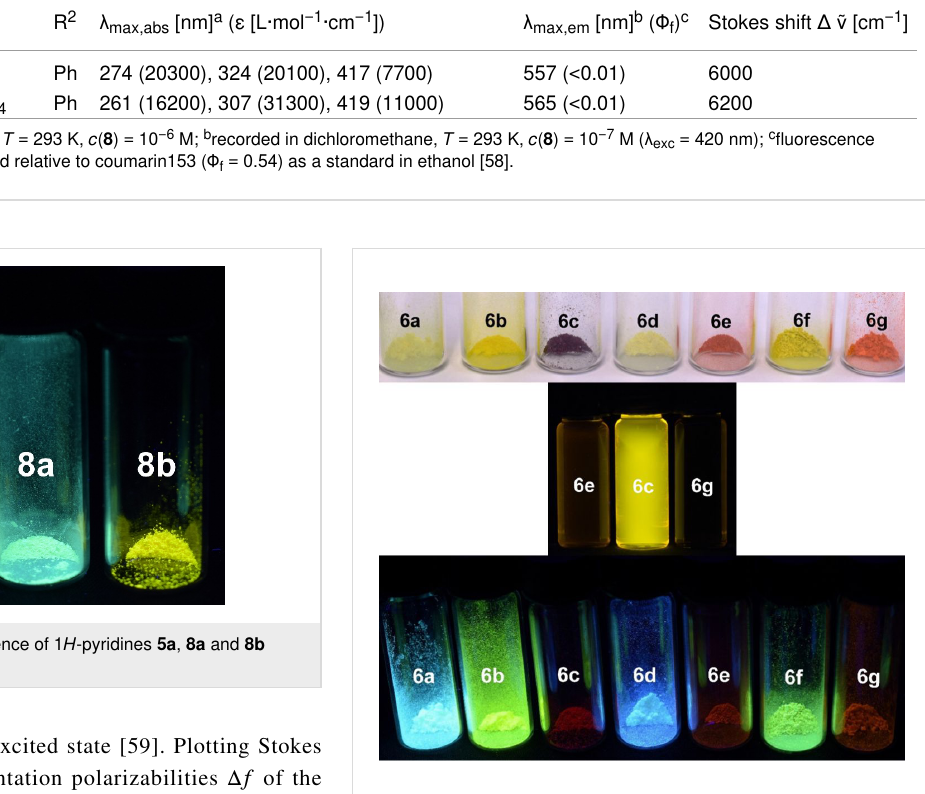
the vibrationally relaxed excited state [59]. Plotting Stokes shifts Δν̃ against the orientation polarizabilities Δ ƒ of the respective solvents (Lippert plot) [60] gives a reasonable linear correlation with a moderate fit of r 2 = 0.970 (Figure 13). The orientation polarizabilities Δ ƒ were calculated according to Equation 1